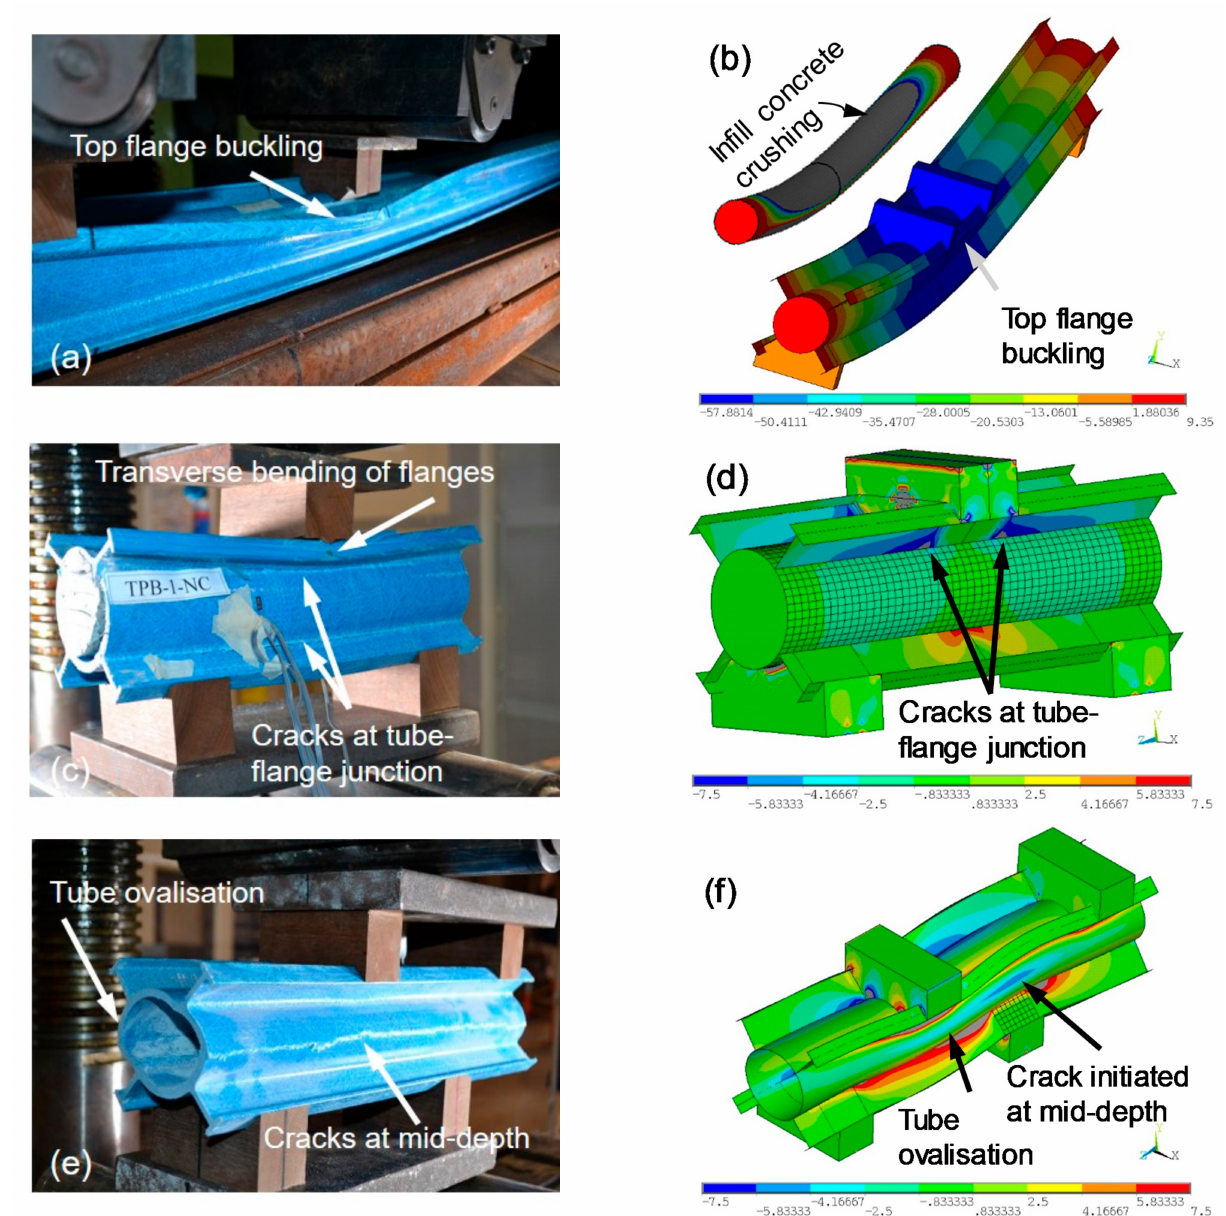
Figure 4. Comparison between experimental and FE results based on failure modes ( a ) FPB test, ( b ) FE model for FPB ( c ) SBS test, ( d ) FE model for SBS, ( e ) ABS test and ( f ) FE model for